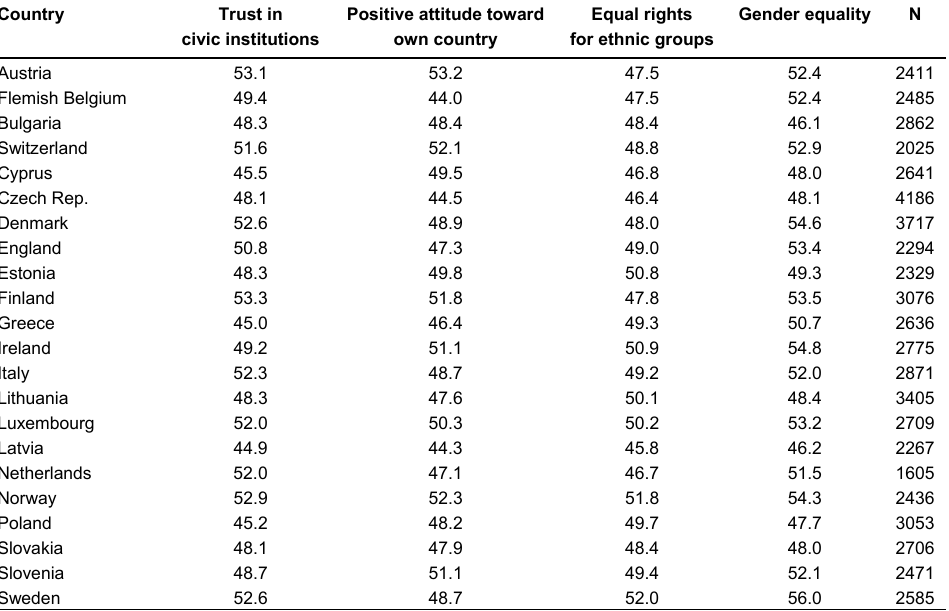
Table A1 : Descriptive statistics by dependent variable and country